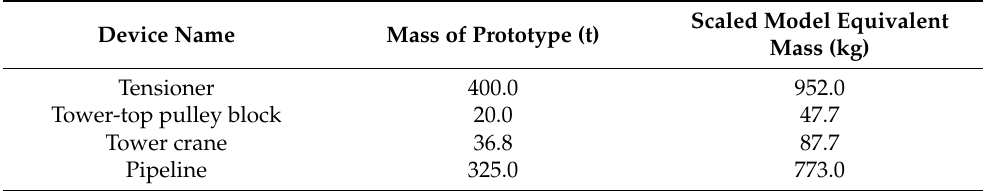
Table 4. Equivalent force to be applied by the scaled